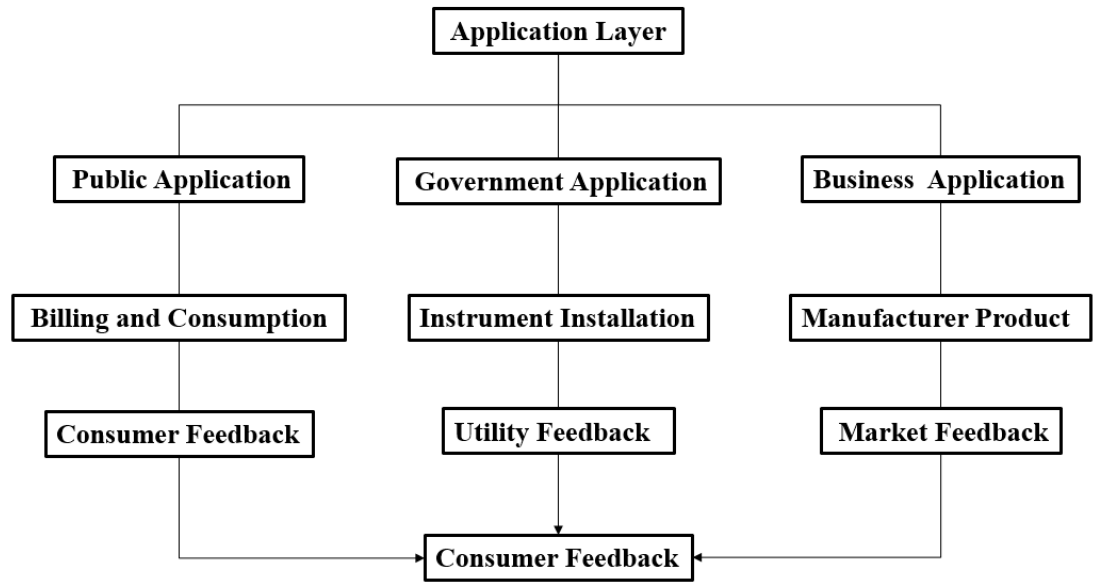
Figure 10. Application layer designing.